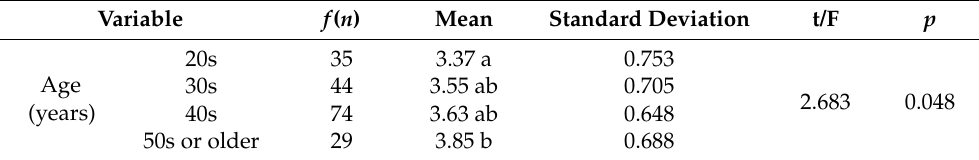
Table 6. Interior design factor in relation to the respondents’ personal and professional characteristics.